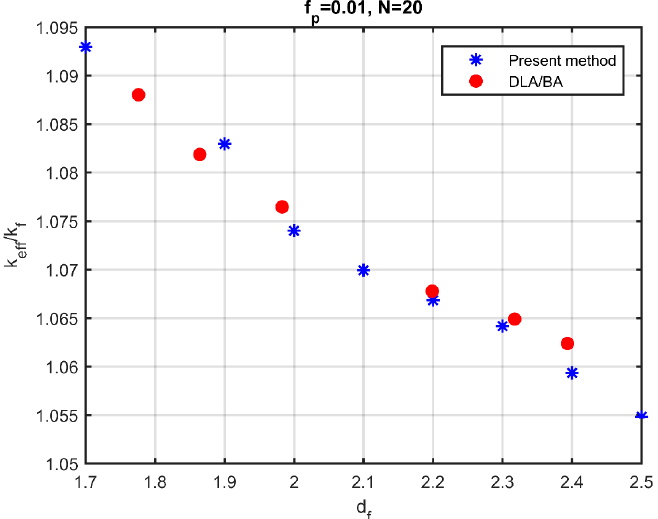
Figure 8. Effective thermal conductivity as a function of the fractal dimension of aggregates by the present method (blue points) and by simulations from [35] (red points). DLA and BA (ballistic) estimates are practically identical.